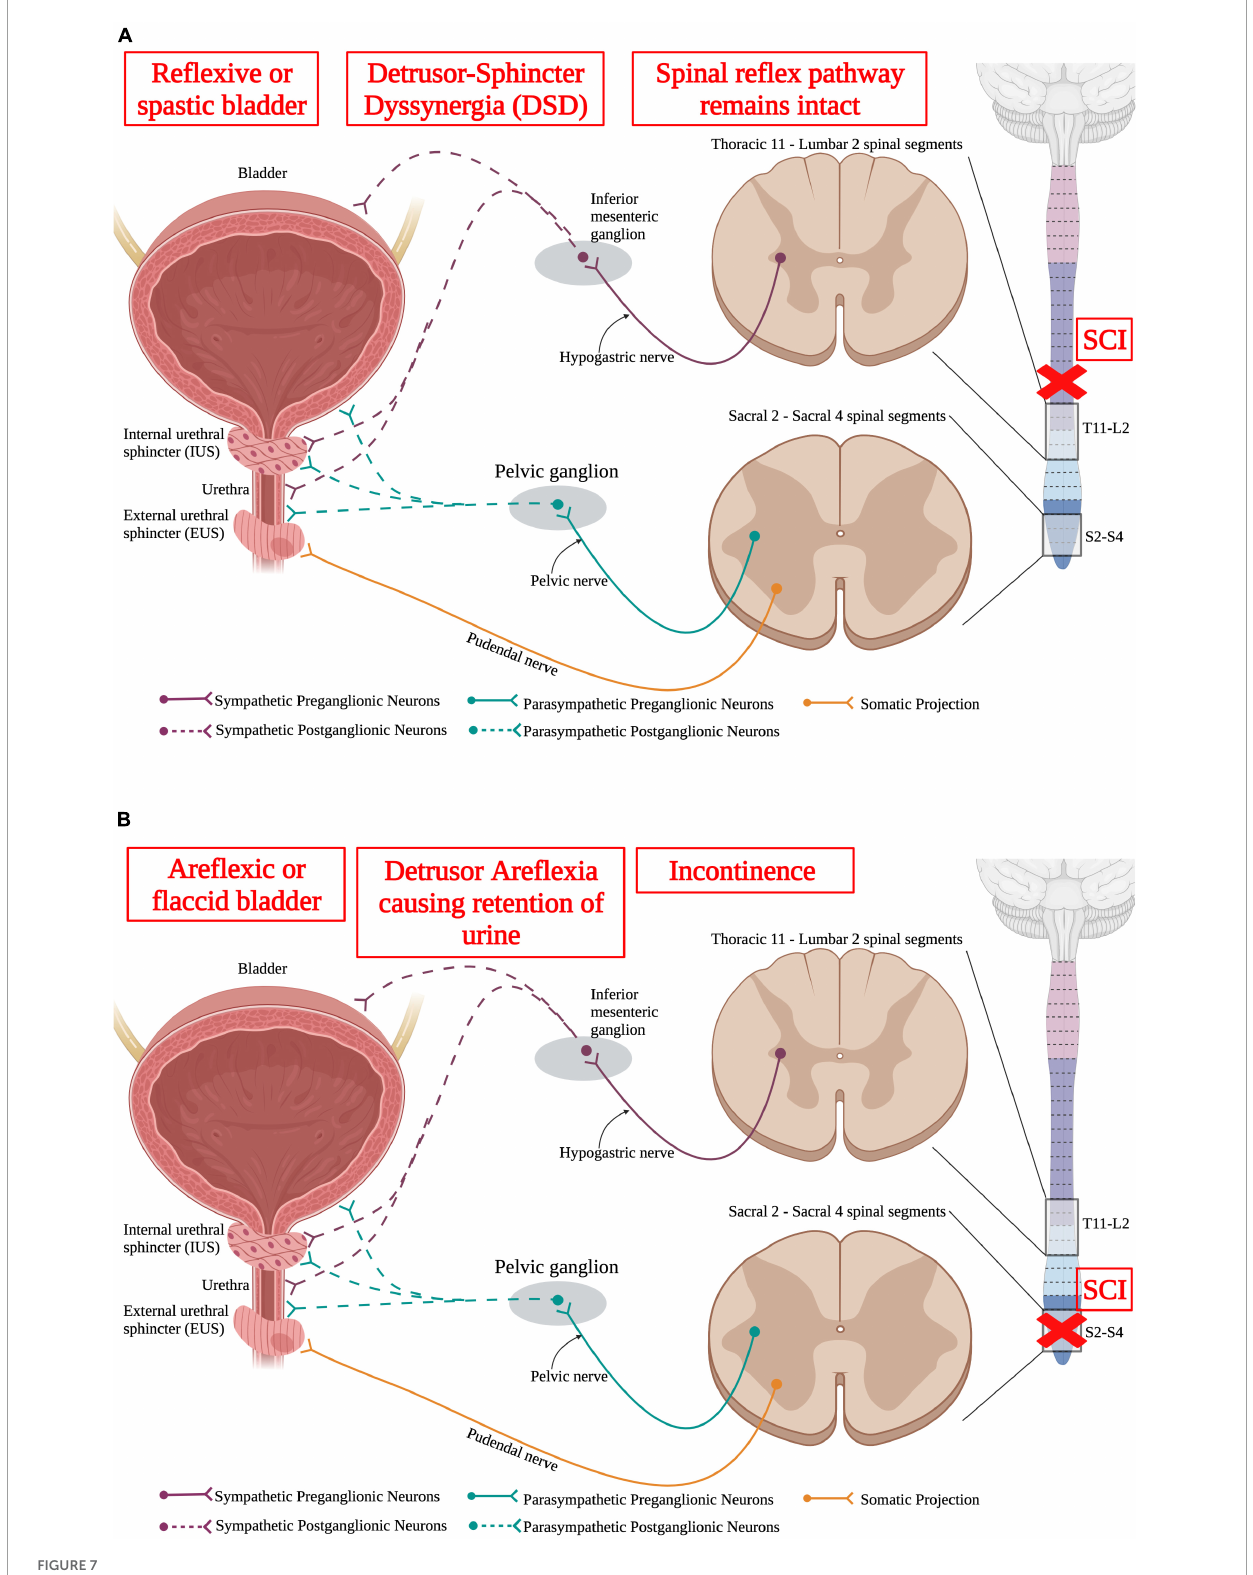
FIGURE7 Spinal cord injury results in lower urinary tract (LUT) dysfunction. (A) An upper motor neuron injury is when there is no direct damage of the neurons that innervate the bladder, leaving the spinal reflex pathway intact. An upper motor neuron injury results in a reflexive or spastic bladder and detrusor-sphincter dyssynergia (DSD), where the detrusor and sphincter muscles abnormally contract simultaneously, resulting in inefficient voiding. (B) Lower motor neuron injury results in damage to the neurons that directly innervate the bladder. A lower motor neuron injury produces an areflexic or flaccid bladder where the detrusor muscle does not contract. This results in retention of urine in the bladder that makes the bladder become over-stretched. (Created using